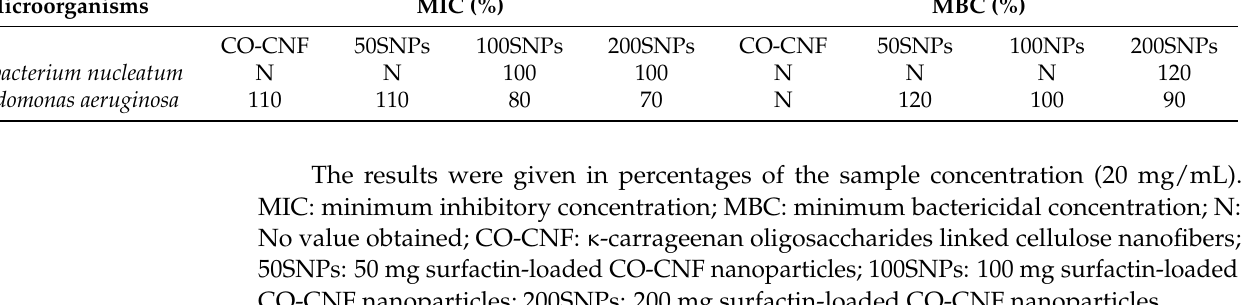
Table 1. Evaluation of the Minimum Inhibitory Concentration (MIC) and Minimum Bactericidal Concentration (MBC) of nanoparticles. Microorganisms MIC